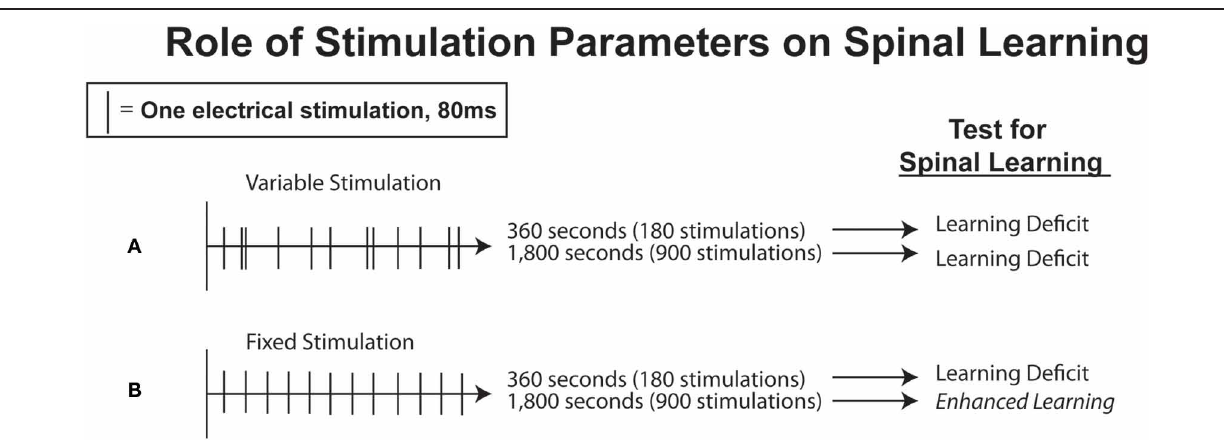
(B) If stimulation is administered to the tail with a fixed interval between stimulations over the course of 360s, rats will also later fail to learn, but if the train of fixed stimulation is extended to 1800s rats then exhibit enhanced learning when later tested. Adapted from Baumbauer et al.